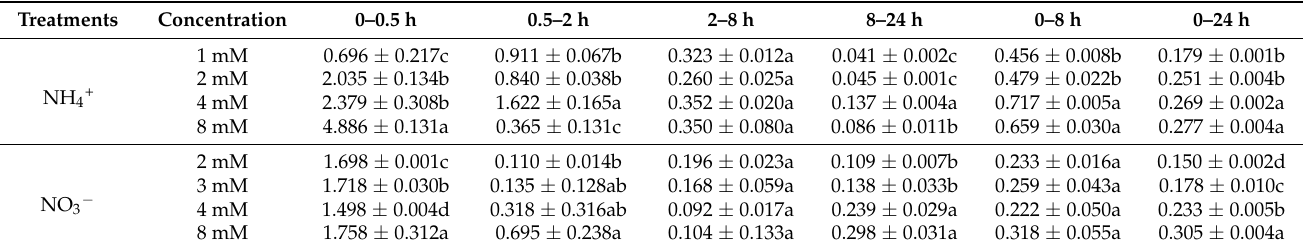
Table 2. Effects of different N sources on the N uptake rate of flowering Chinese cabbage (unit: mmol L − 1 h − 1 ).